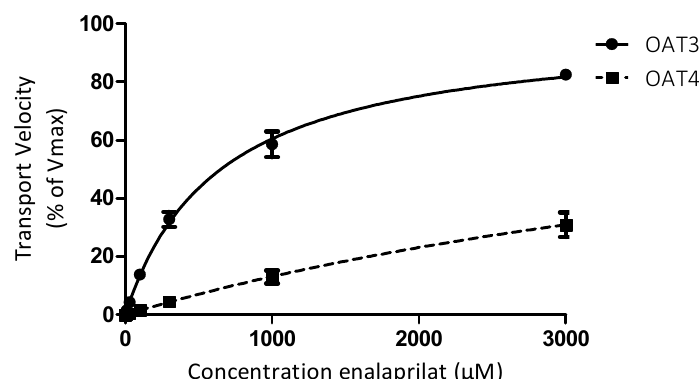
Figure 5. Concentration-dependent uptake of enalaprilat by OAT3 and OAT4. Michaelis–Menten kinetic curves showing the relationship between enalaprilat concentration and transport velocity of OAT3 and OAT4. For OAT3, a Km value of 640 µM (95% CI 510–770 µM) was observed, whereas saturation of transport via OAT4 was not reached over the concentration range measured. Transport velocity is expressed in percentage of maximum velocity and presented as mean ± SEM for each data point. Data were pooled from three independent experiments.